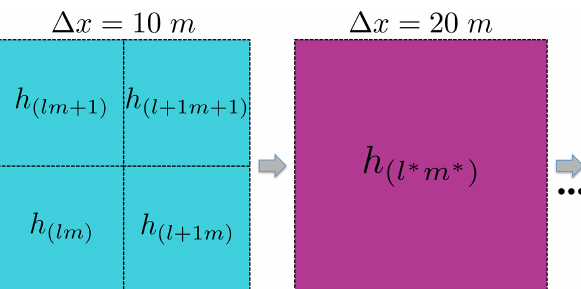
Figure 7. Schematic of the coarse-graining procedure. The thick- ness field is defined at 10m resolution (blue cells on the left). The thickness field at 20m resolution is obtained by averaging the h val- ues of the four 10m cells contained in the 20m one (purple cell). This procedure is repeated for the other lower resolutions. The same method is applied for the concentration A . The indices l,m are for the 10m grid, while the indices l ∗ ,m ∗ are for the 20m grid.